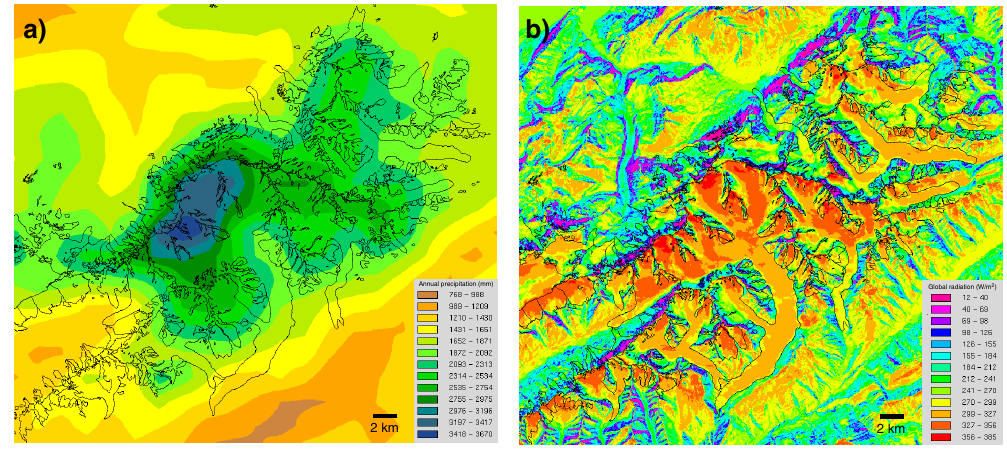
Fig. 2. (a) Mean annual precipitation from the Schwarb et al. (2001) climatology resampled from 2km to 25m cells with glacier outlines from 1850. (b) Mean daily potential global radiation as modeled by SRAD for day 212 of a year (31 July) using the reconstructed DEM from